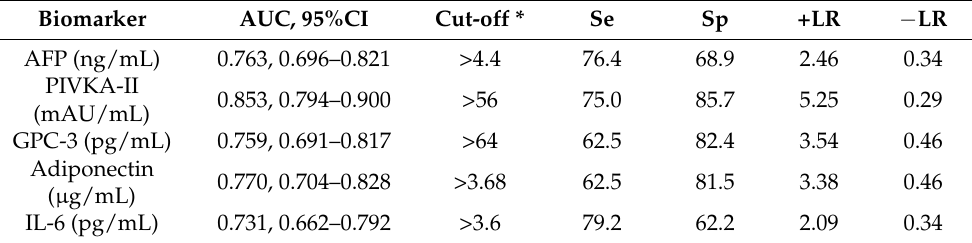
Table 3. Diagnostic accuracy of AFP, PIVKA-II, GPC-3, adiponectin and IL-6 discrimination between the patients with and without HCC.